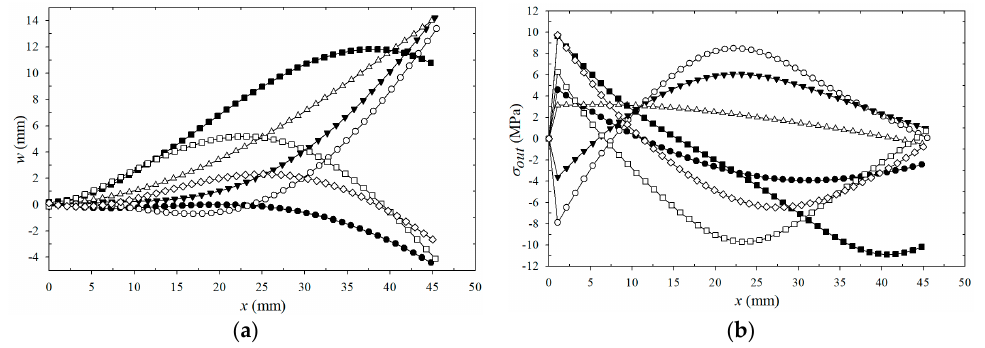
Figure 17. L = 50 mm, D = 10 mm, u f = 30 m/s, RE = 20,000, t p = 240 µm plate: ( a ) Characteristic deflected shapes ; ( b ) stress distribution on the outer fiber for the deflected shapes.